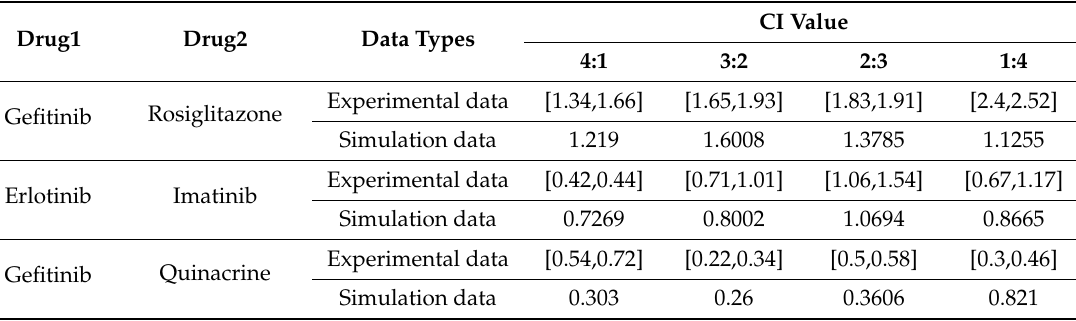
Table 5. The comparison of CI